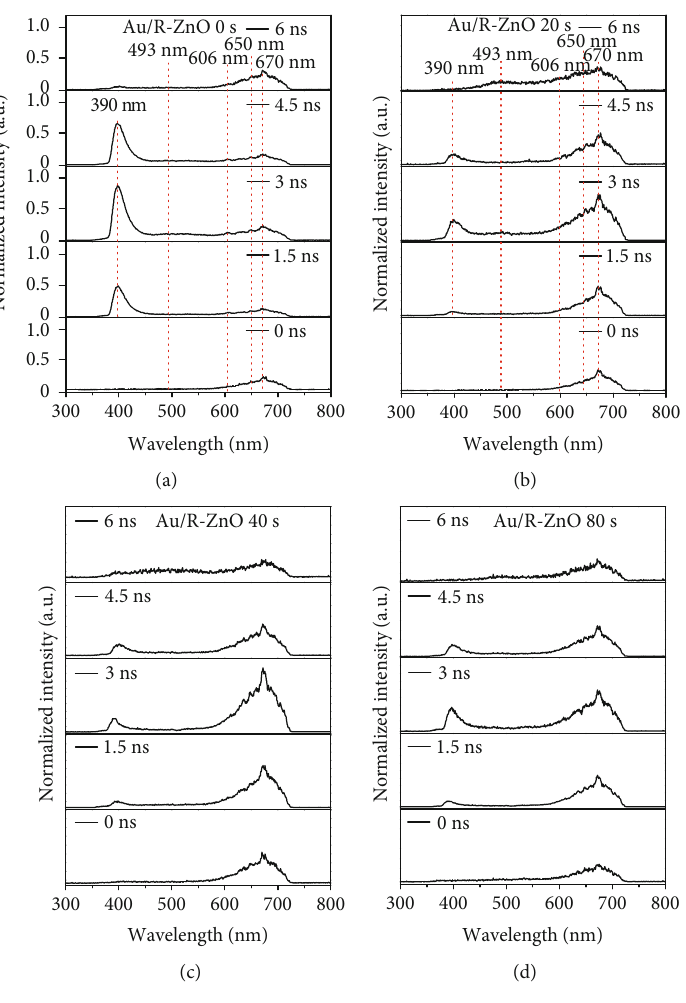
Figure 12: (a) – (d) The normalized NTRT-PL spectra of pristine R-ZnO, and Au/R-ZnO Schottky heterojunction nanocomposites for di ff erent deposition times (20s, 40s, and 80s), respectively.